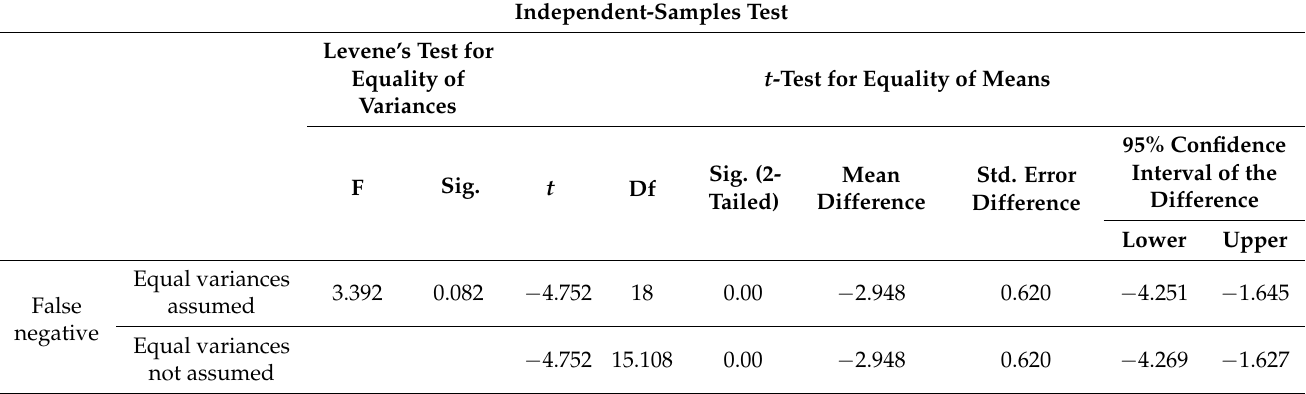
Table 11. Independent-sample test significance computation between ECNN and CNN for false negative.